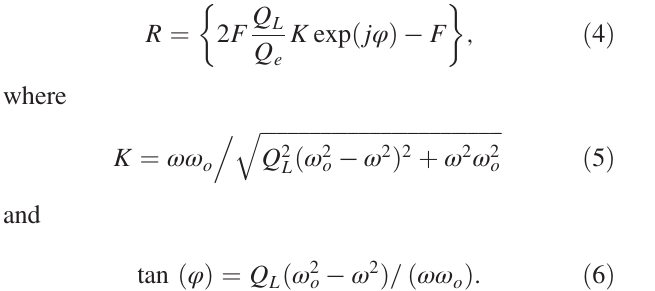
TABLE I. j R ð F 2 Þj after a change in the drive phasor from 1 to F 2 for Q